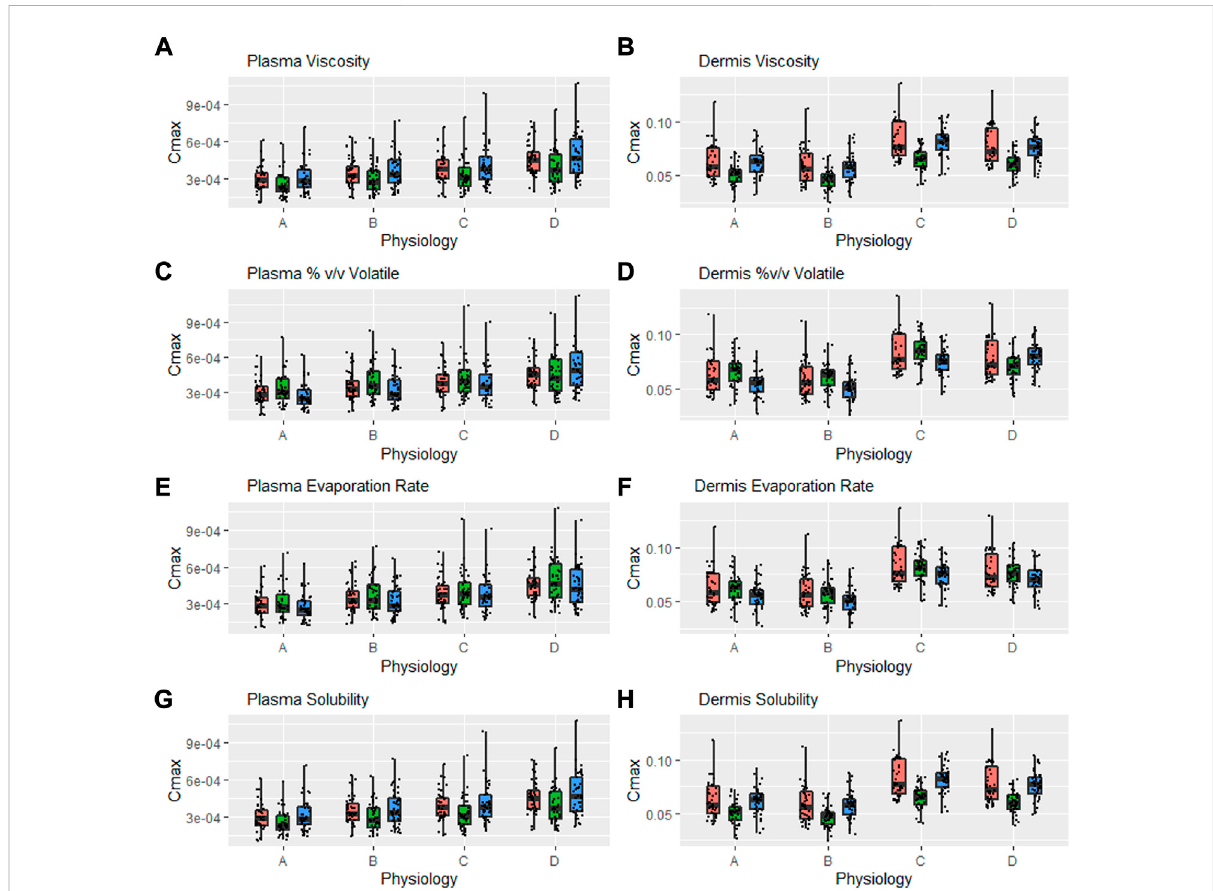
FIGURE 6 Interaction between formulation parameters and different physiology scenarios for C max in plasma and dermis; viscosity (A,B) , %(v/v) volatile fraction (C,D) , evaporation rate (E,F) and solubility of drug in the continuous phase (G,H) . Red bars represent RLD parameter value, Green = Upper bound and Blue = Lower bound